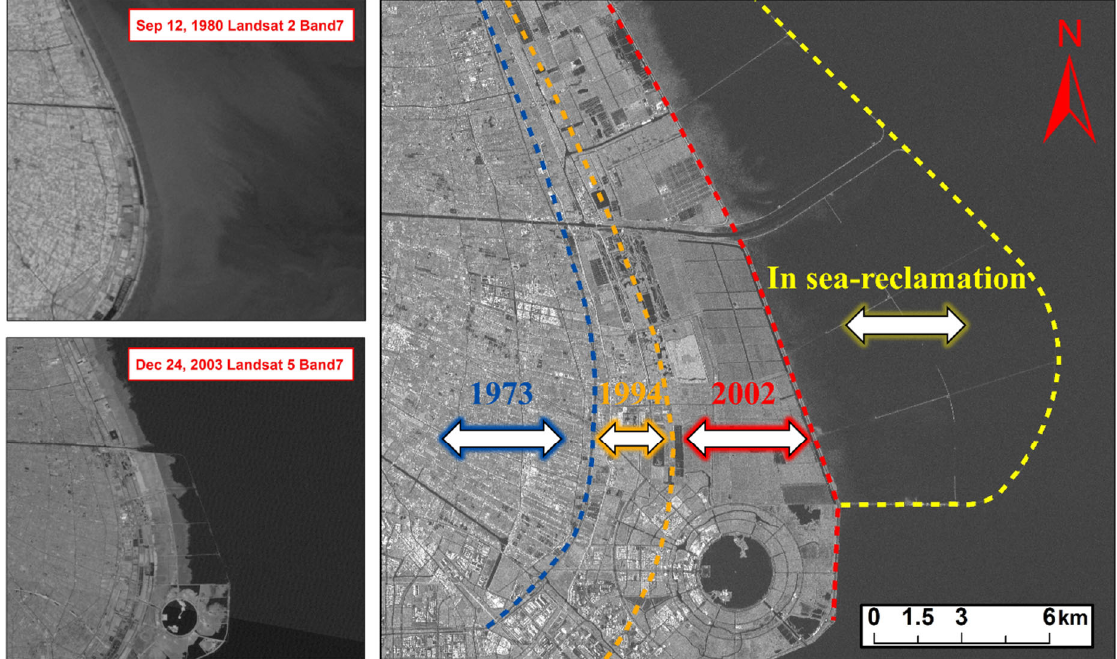
Figure 15. Reclamation area in Shanghai (the blue, orange and red lines are the borders up to 1973, 1994, and 2002, respectively, while the yellow line is an area currently being filled).